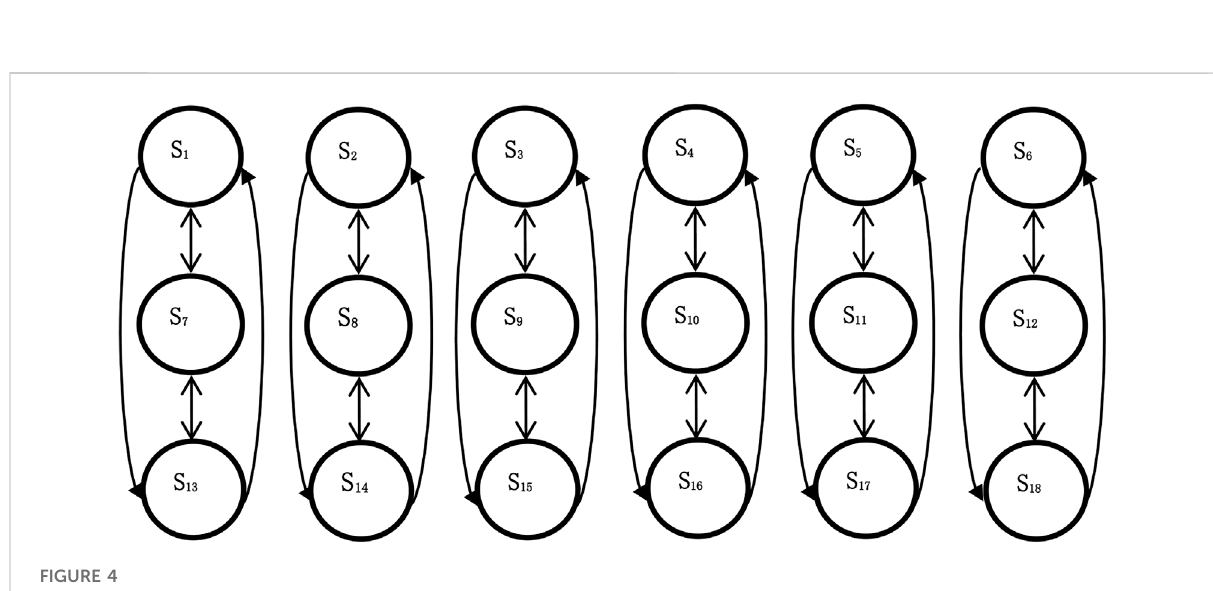
FIGURE 4 Government ’ s state transition